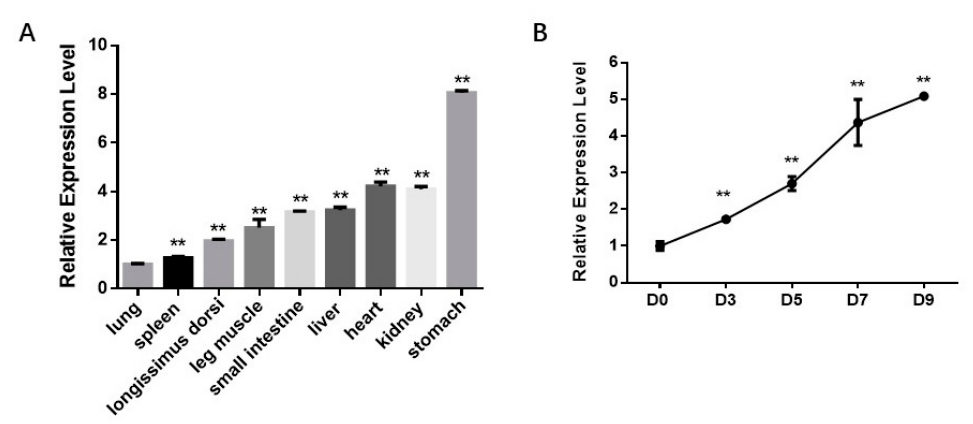
Figure 2. bta-miR-210 expression in fetal tissues and during intramuscular adipogenesis. ( A ) bta-miR-210 expression level in fetal tissues. All the measurements shown are the means ± SEM (standard error of the mean) of three individual biological replicates. ( B ) Relative expression of bta-miR-210 during PDGFR α⁺ cell adipogenic di ff erentiation at Day 0 (D0), Day 3 (D3), Day 5 (D5), Day 7 (D7) and Day 9 (D9), respectively. All the measurements shown are the means ± SEM of four biological replicates from independent cell experiments. ** p <